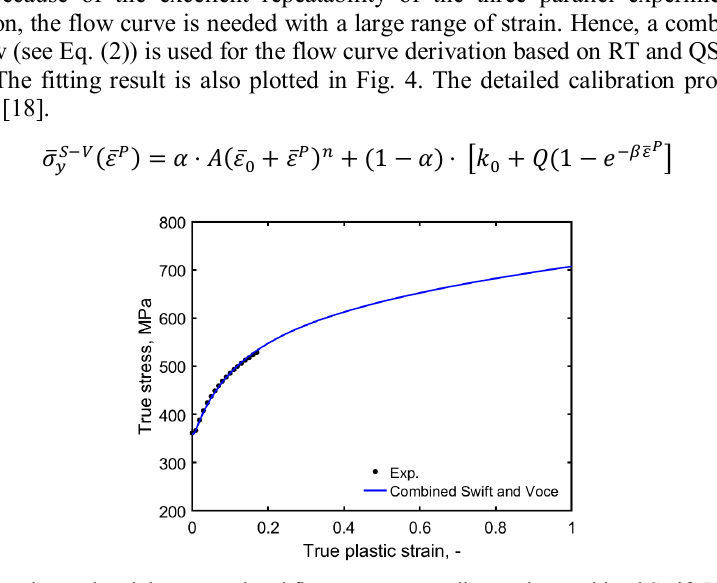
Fig. 4. Experimental and the extrapolated flow curves according to the combined Swift-Voce